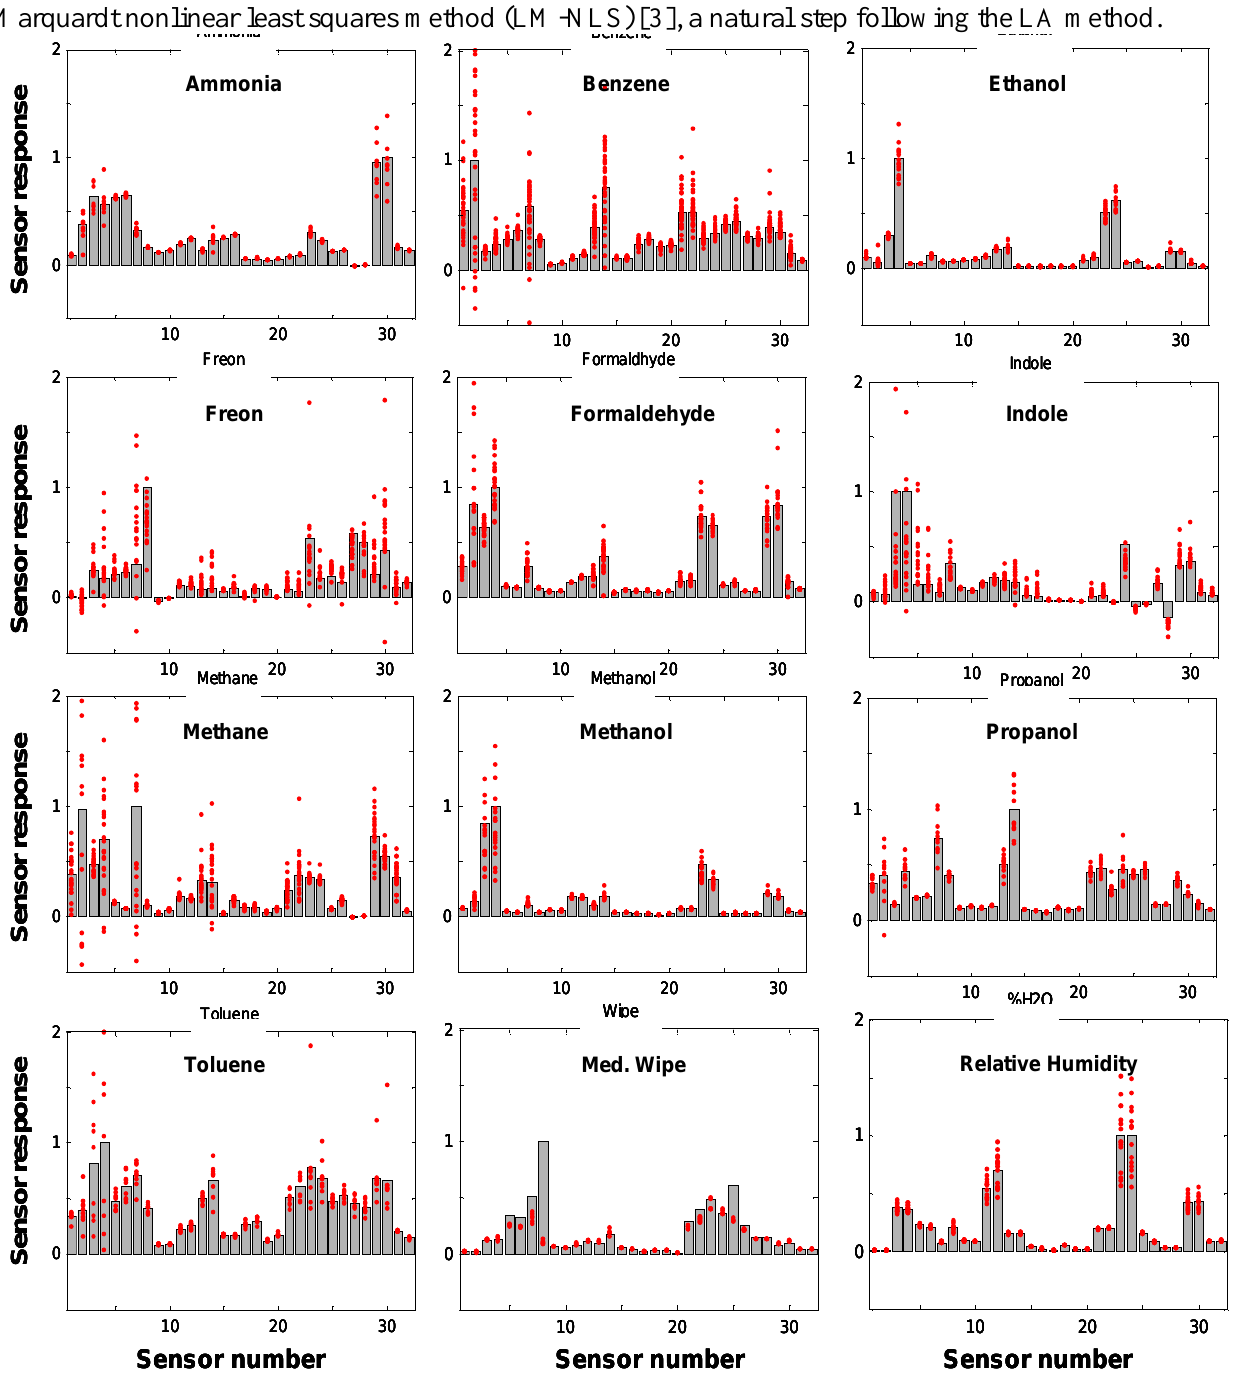
Figure 1. Signatures generated by the ENose sensor. Average variations are as large as 75% for methane and Freon and ~50% for indole and benzene; even in good cases (e.g., ammonia, propanol, and ethanol), we see an average variation of 25-30%. The vertical axis is the normalized resistance change calculated as D R/R where R is sensor resistance immediately before the start of an event. The 0 0 horizontal axis is the sensor sequence number. Bars show the least-squares fitted signature; dots show the actual signatures generated by the ENose sensor array. Notice the similarity of signatures for ethanol and